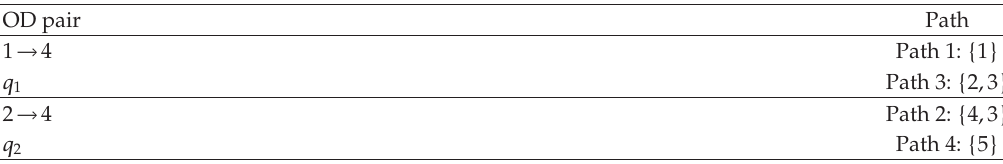
Figure 4: State trajectories demonstrating stability of UE flow on Path 1. Table 2: OD pairs and path